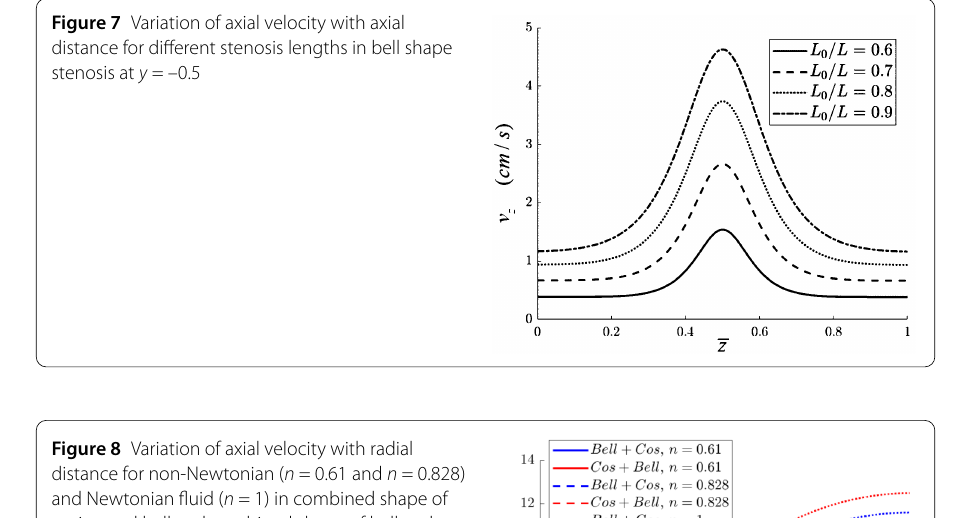
Figure 8 Variation of axial velocity with radial distance for non-Newtonian ( n = 0.61 and n = 0.828) and Newtonian fluid ( n = 1) in combined shape of cosine and bell and combined shape of bell and cosine stenosis at ¯ z = 0.8